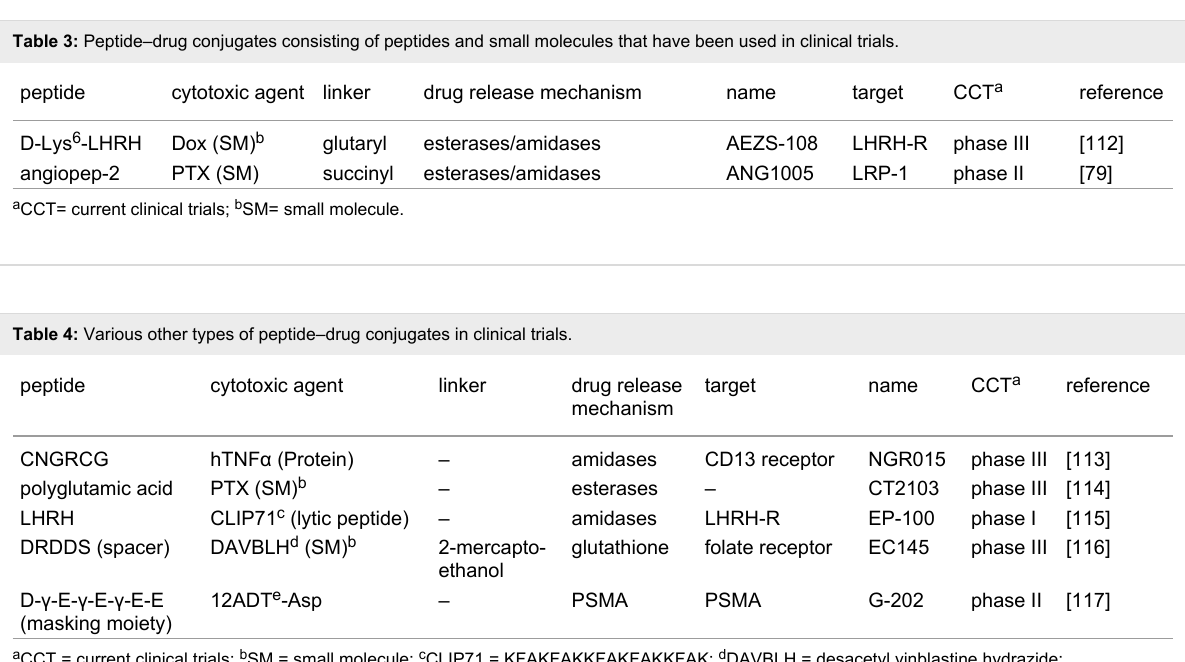
various other similar PDC formulations existed in the current literature that have been evaluated in preclinical